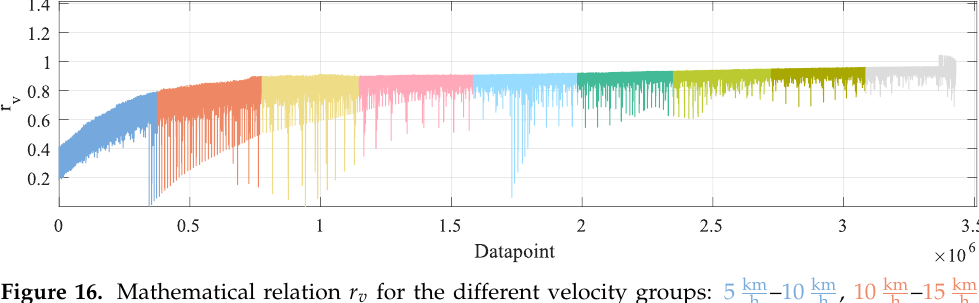
Figure 16. Mathematical relation r v for the different velocity groups: 5 km –10 km , 10 km –15 km , h h h h 15 km –20 km , 20 km –25 km , 25 km –30 km , 30 km –35 km , 35 km –40 km , 40 km –45 km , 45 km –50 km . h h h h h h h h h h h h h h